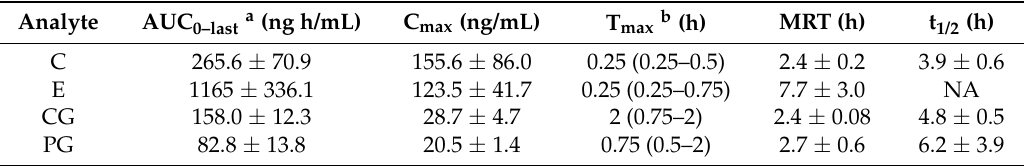
Table 5. The pharmacokinetic parameters of anthraquinones after oral administration of R. acetosa extract to rats at a dose of 2 g/kg ( n = 3).